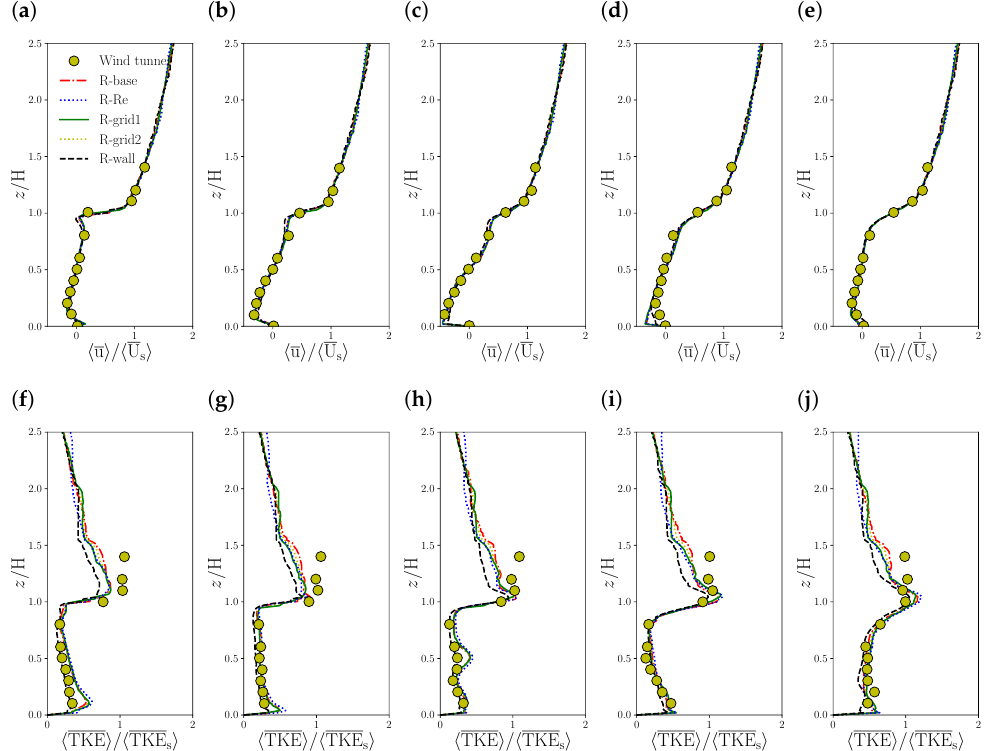
Figure A4. As in Figure 2, but for the runs of Table A3. Validation of the IDDES model (OpenFOAM) for neutral flow over a 2-D street canyon. Normalised mean streamwise velocity and TKE validation of IDDES (solid line) against wind tunnel experiment [54] (filled circles) at ( a , f ) x / W = ( b , g ) x / W = 0.25; ( c , h ) x / W = 0; ( d , i ) x / W = 0.25; ( e , j ) x / W = 0.4. Reference values for the − U s TKE s streamwise velocity and TKE, and , represent averages of the IDDES data over the shear (cid:104) (cid:105) (cid:104) (cid:105) z / H layer, 1 ≤ ≤